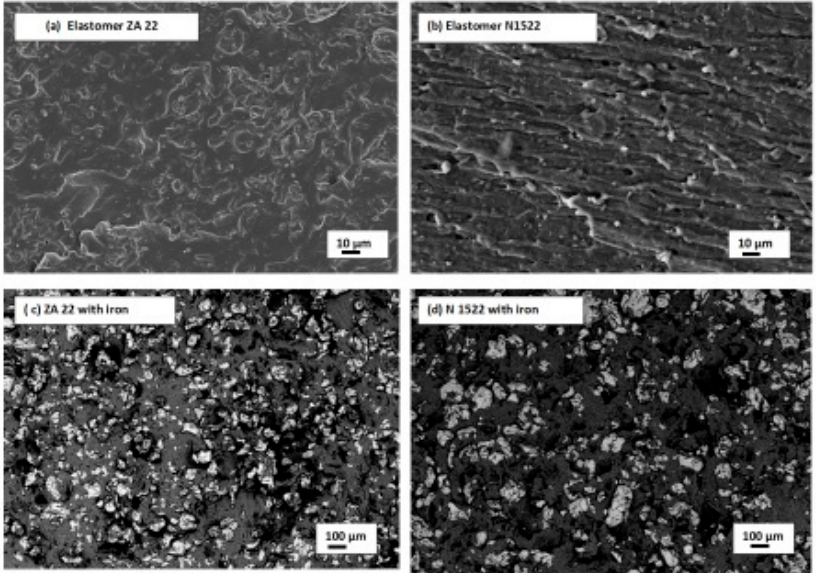
Figure 10. ( a , b ) Microstructural image of elastomer matrix and ( c , d ) scanning electron microscopic image of isotropic distribution of filler particles within the matrix of the composite.